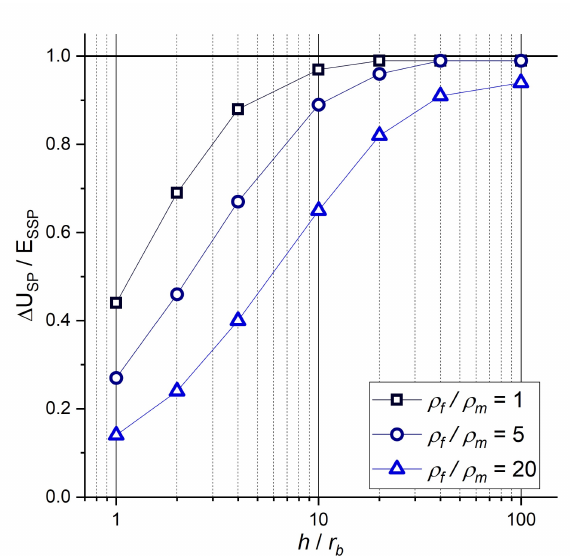
Figure 6. Dependence of SP anomaly amplitude, normalized to the value of static SP, on the thickness of the permeable formation for different relationships between the resistivity of the sandstone formation and the drilling